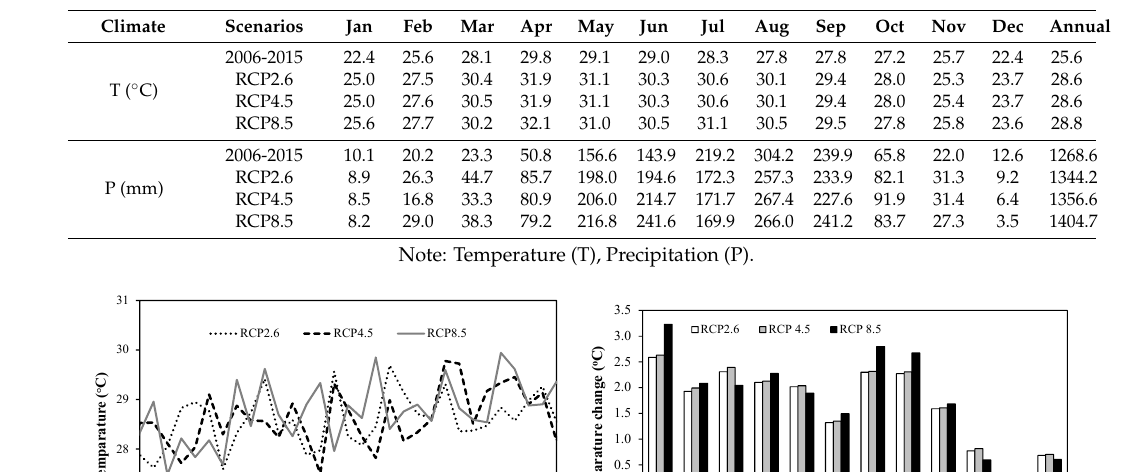
Table 5. Future average monthly precipitation and temperature scenarios projected by climate models from 2016 to 2045.